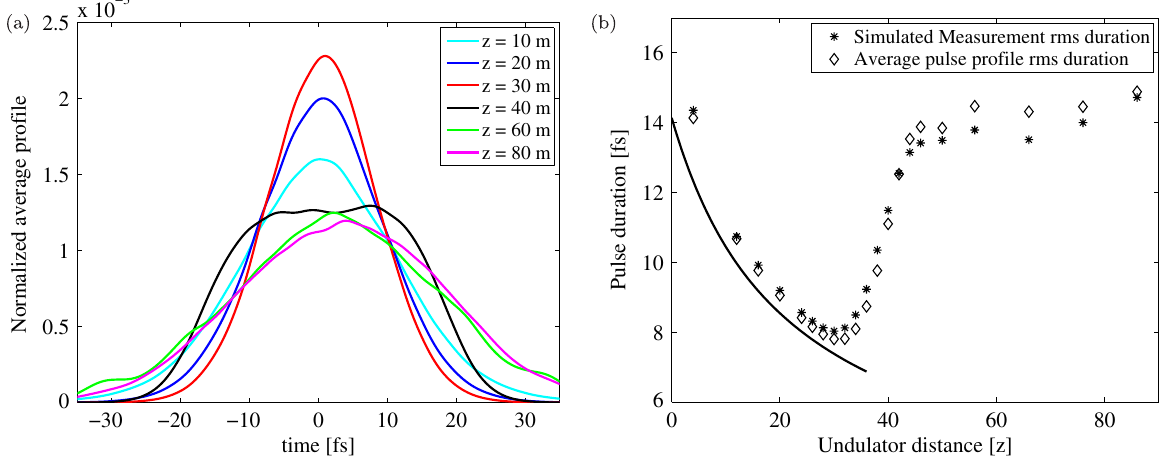
FIG. 5. Results for the Gaussian electron bunch profile with 6 (cid:7) m rms length. (a) Normalized average x-ray profile. A low pass filter has been used to remove the residual spiky structure from the 500 shots average. (b) Pulse duration vs undulator distance. Calculated average profile rms duration (diamonds), simulated measurement rms duration (stars).